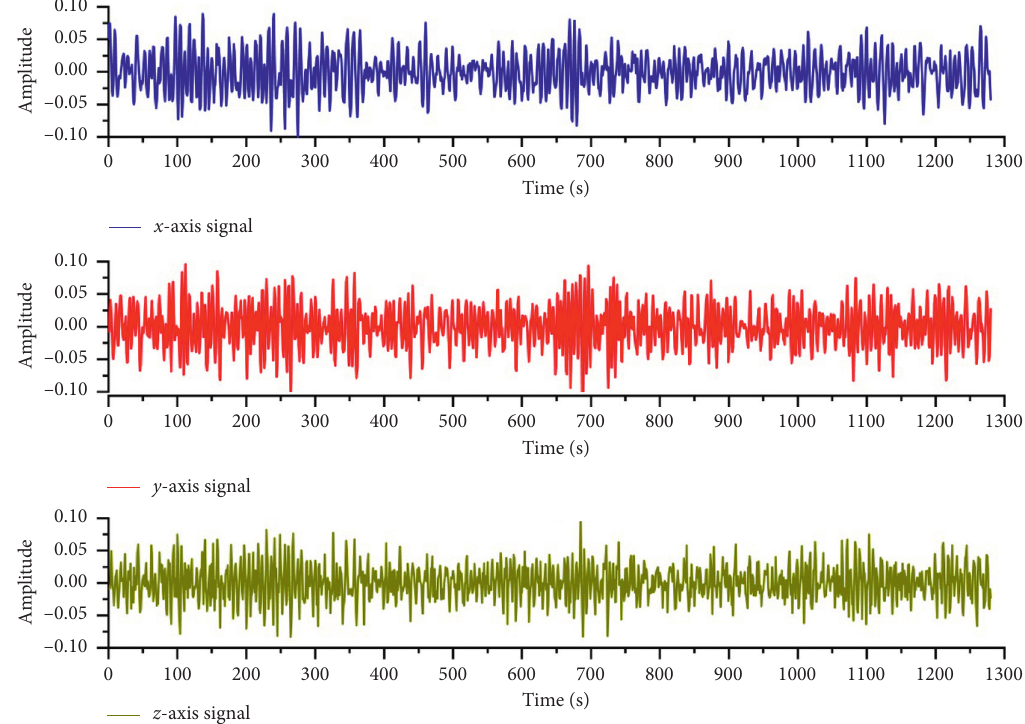
Figure 4: Amplitude curve of the original signal in three axial directions.